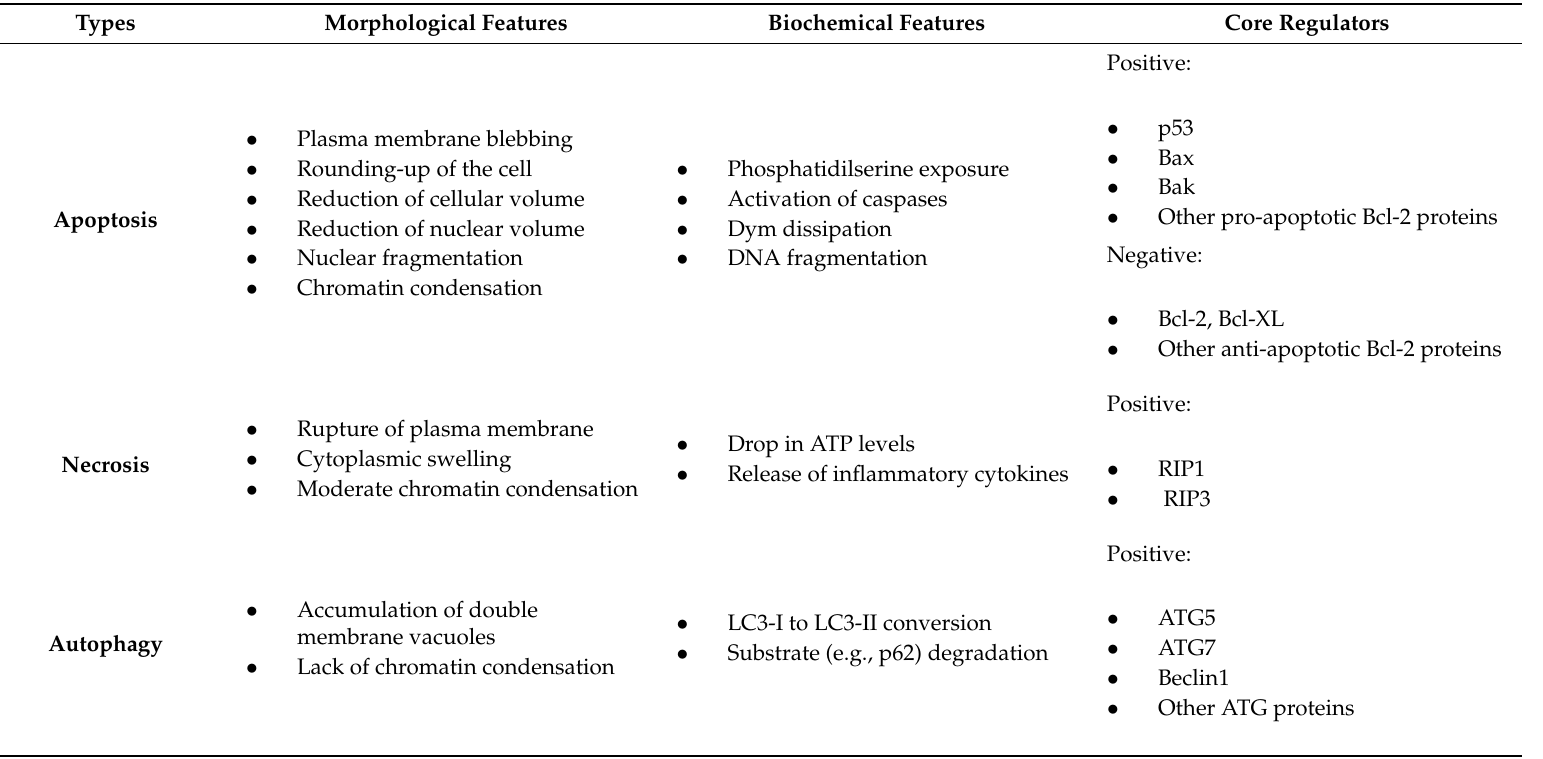
Table 1. The main morphological, biochemical and molecular characteristics of apoptosis, necrosis and